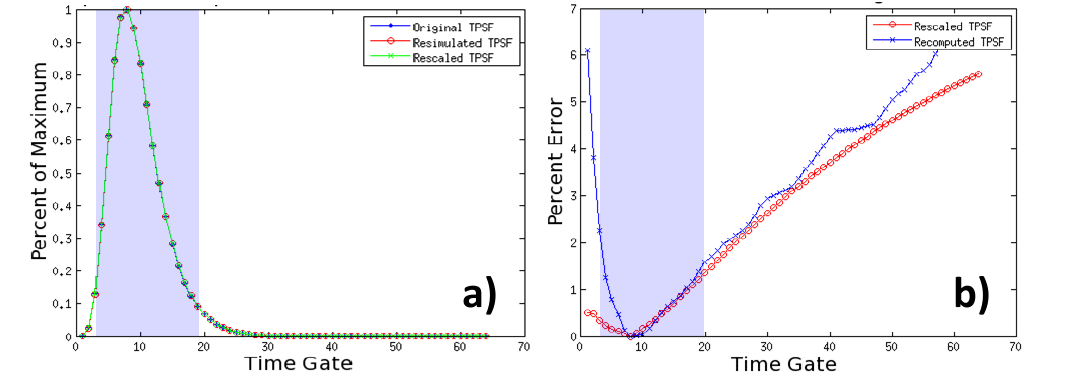
Figure 8. Temporal Point Spread Function (TPSF) of Jacobians rescaled to a new mesh and the associated error at each